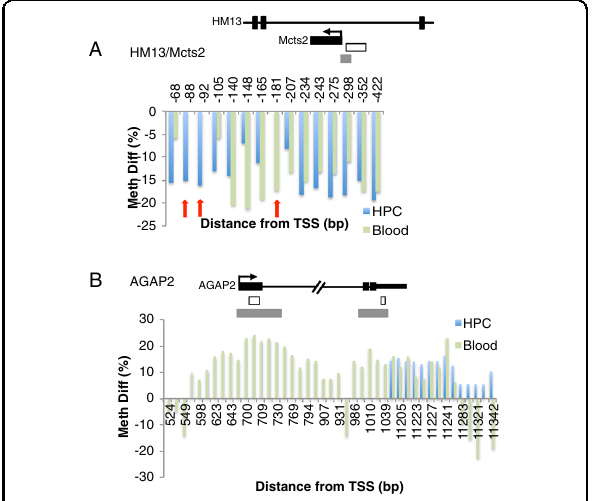
Fig. 3 Examples of genes showing both differentially methylated regions (DMRs) that are similar across the hippocampus (HPC) and whole blood as well as tissue-type speci fi c DMCs. The top of each panel shows the genomic region examined for A HM13/Mcts2 and B AGAP2 . The white horizontal boxes represent observed DMRs. The gray horizontal boxes represent CpG islands. In the bar graphs, the x -axis shows the distance in base pairs from the transcription start sites, while the y -axis shows the methylation percentage difference between sGC treatment and saline controls. Red arrows indicate tissue-type speci fi c DMCs in HM13/Mcts2 .